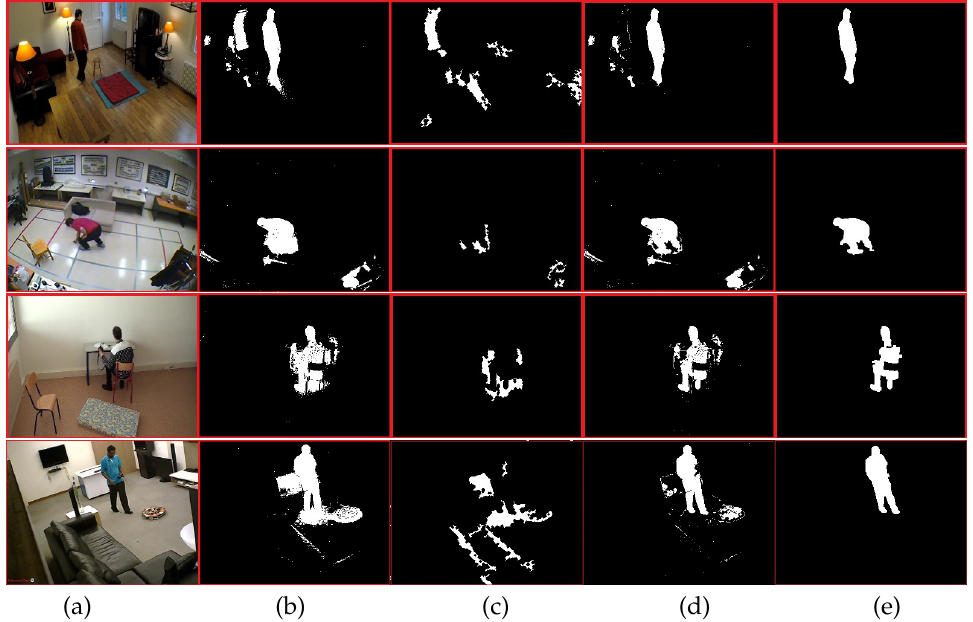
Figure 8. Backgroun subtraction results. ( a ) original frame, ( b ) codebook algorithm result, ( c ) shadow detection, ( d ) difference between image ( b ) and image ( c ). ( e ) The human silhouette detection after applying simple morphological